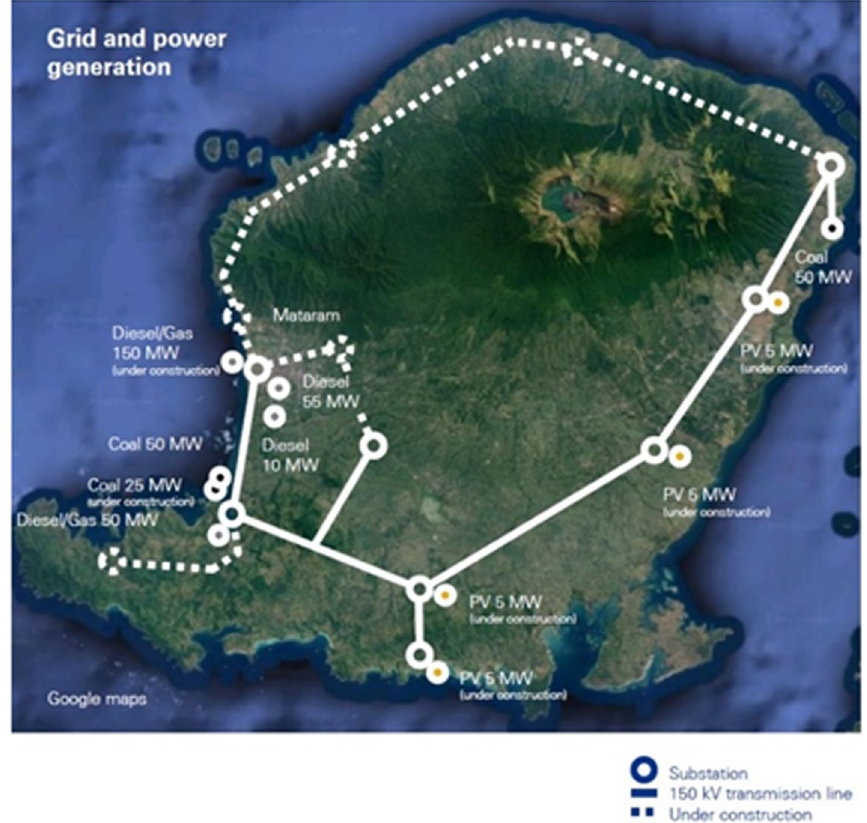
Fig. 4 Lombok electricity system with the established and expected transmission grid extensions (Embassy of Denmark (Jakarta), Danish Energy Agency, KPMG